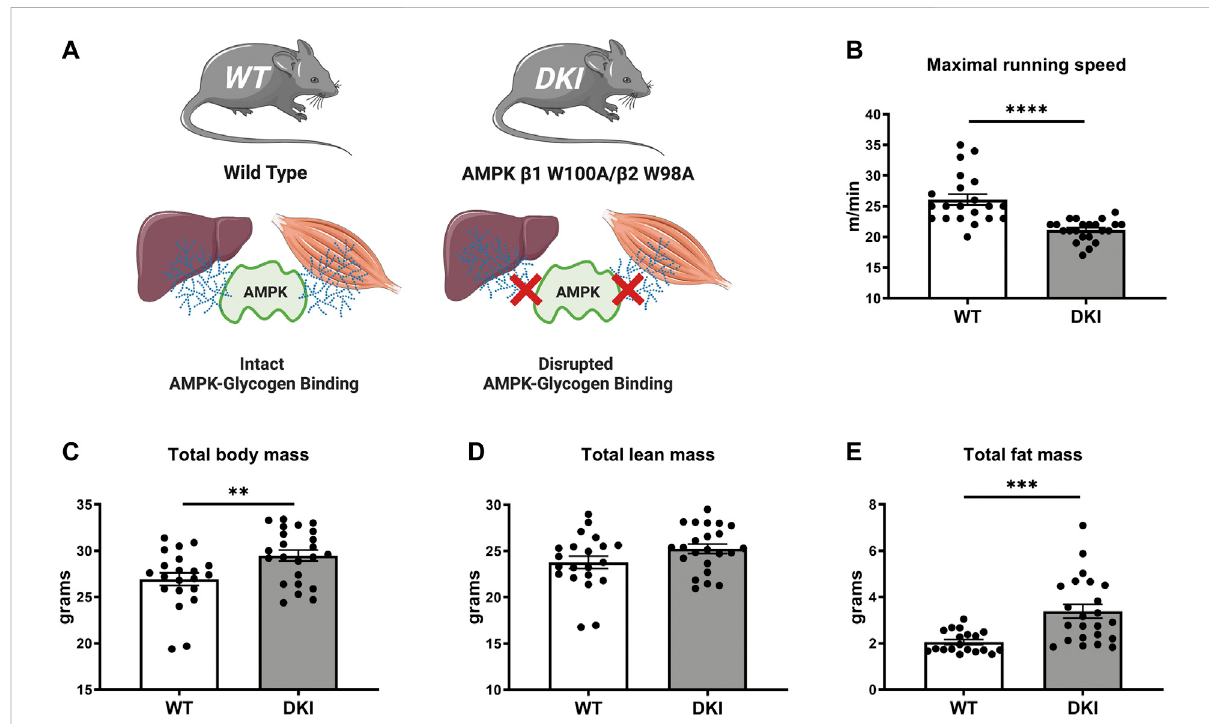
FIGURE 1 AMPK DKI mouse model and phenotypic effects of disrupting whole-body AMPK-glycogen interactions on maximal running speed and body composition. (A) Schematic of WT mice with intact AMPK-glycogen binding and AMPK DKI mice in which critical tryptophan residues within the AMPK β subunit isoforms that mediate glycogen binding ( β 1; predominantly expressed in mouse liver; and β 2 predominantly expressed in mouse skeletal muscle) have been mutated to alanine ( β 1 W100A and β 2 W98A, respectively), resulting in whole-body disruption of AMPK-glycogen binding; (B) Maximal running speed (m/min); (C) Total body mass (g); (D) Total lean mass (g); (E) Total fat mass (g). *: p < 0.05, **: p < 0.01, **** p < 0.0001; values are represented as mean ± SEM; n = 21 – 23 mice per